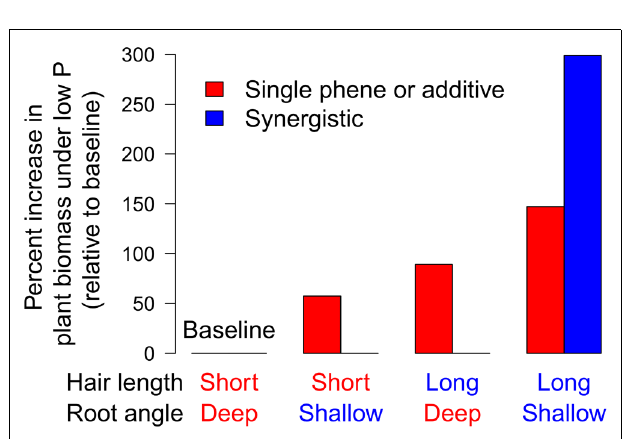
FIGURE 8 | Long root hairs and shallow basal root angles interact synergistically on phosphorus acquisition in the field (created from Miguel,